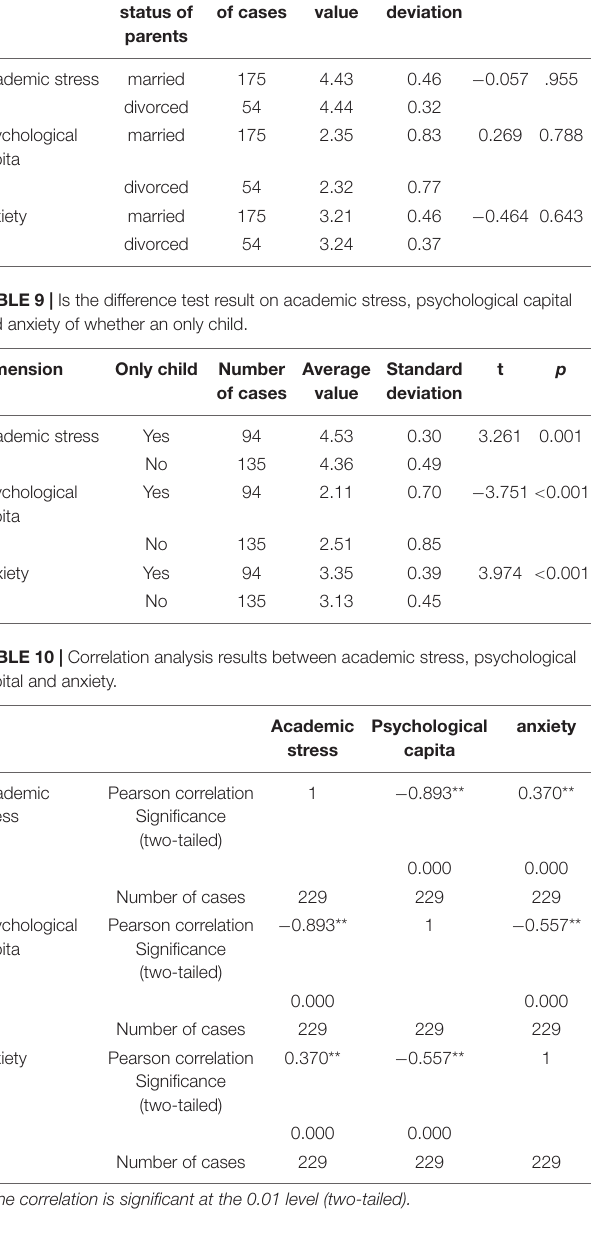
TABLE 8 | Difference test results of parents’ marital status on academic stress, psychological capital, and anxiety. dimension